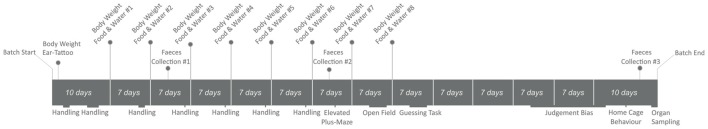
Experimental timeline for a single batch of animals.